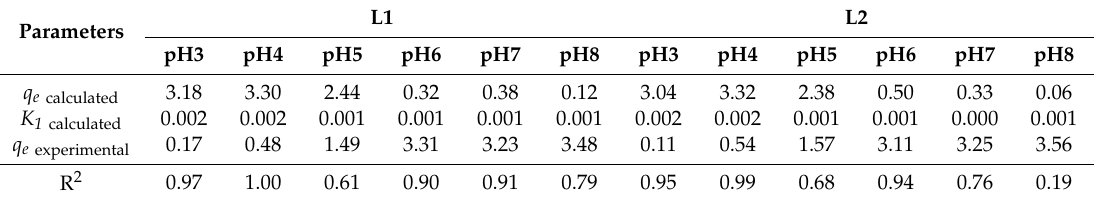
Table 4. Pseudo-second order data for different pH and two types of substrates.